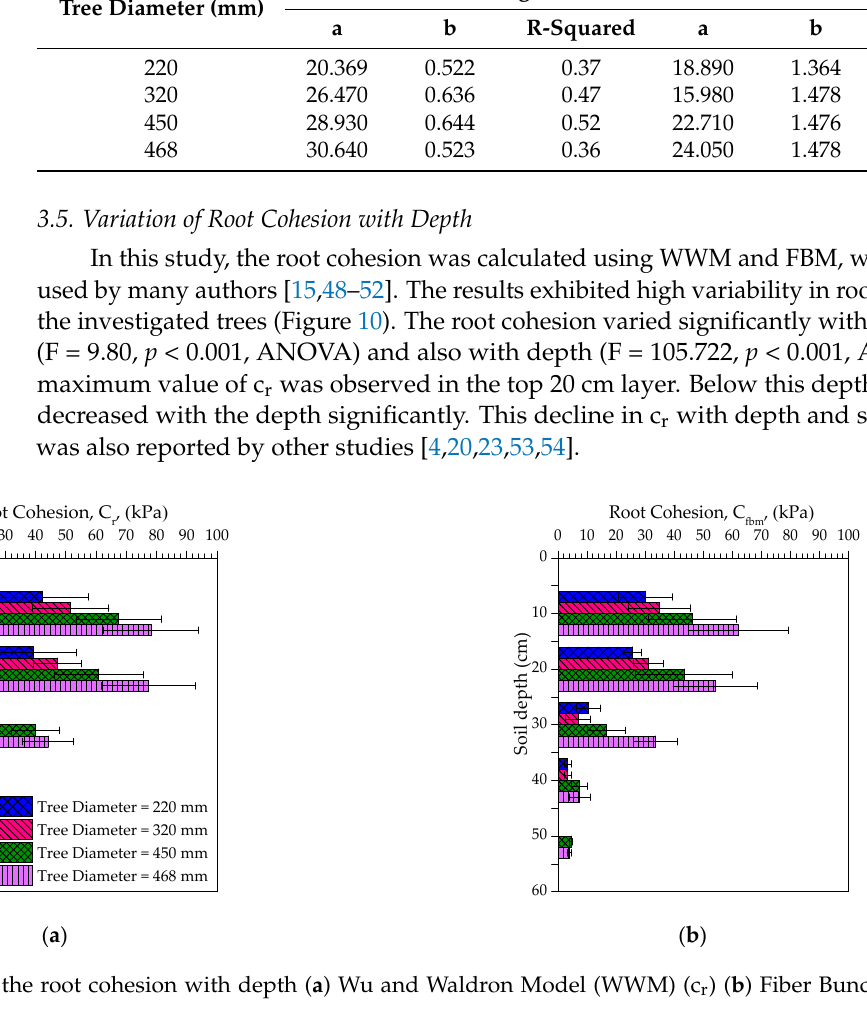
Table 6. Roots cohesion values for investigated species and ratio between WWM and FBM. Depth (cm)